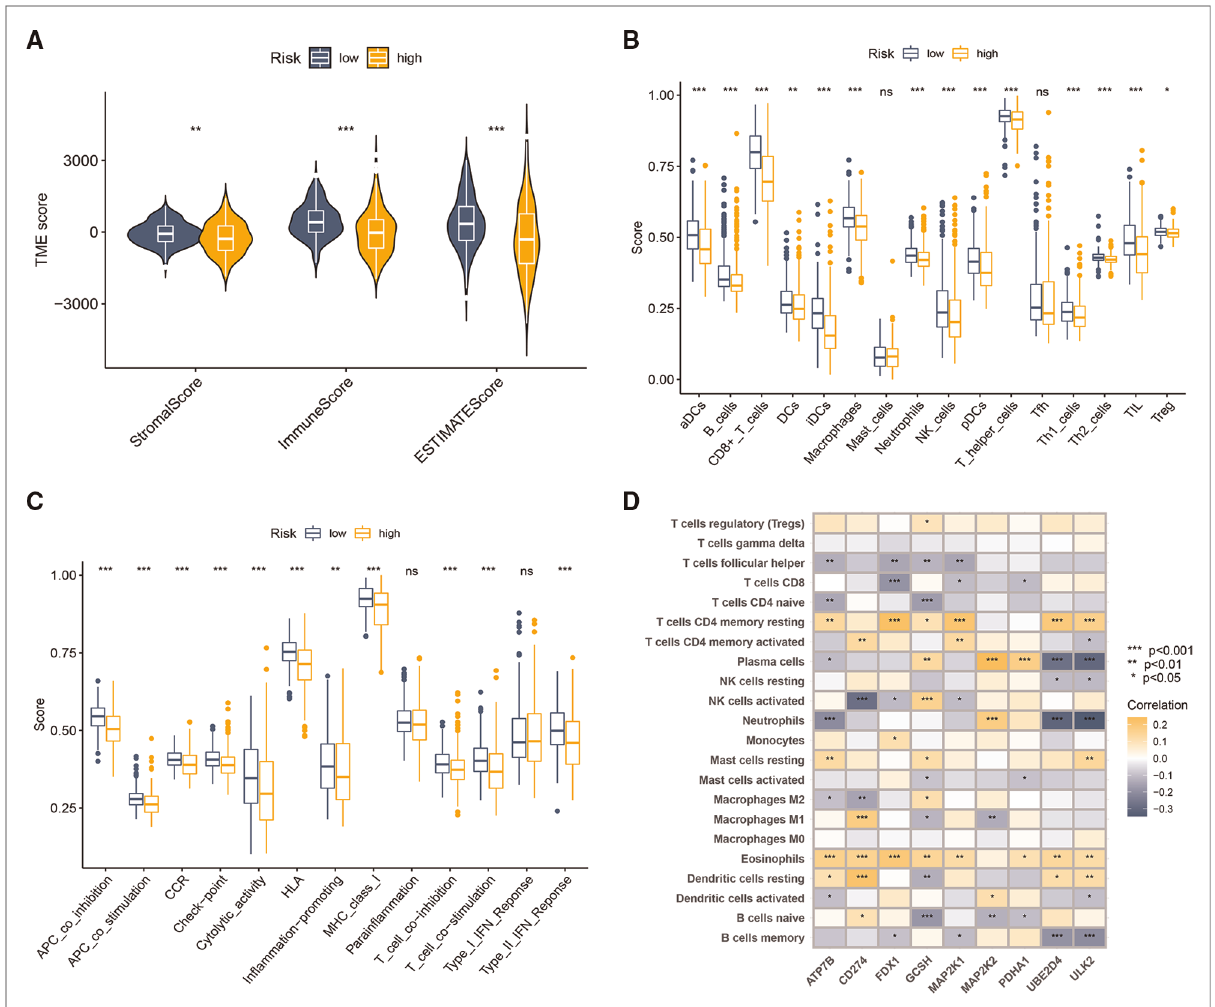
FIGURE 4 Immune-related analysis between high-risk and low-risk groups. ( A ) The variance analysis of the ESTIMATE score, stromal score, and immune score in the different CRG-score groups. ( B ) The immune in fi ltration of immune cell types in high and low CRG-score patients. ( C ) Analysis of immune functions in high and low CRG-score patients. ( D ) Correlation analysis of 9 model CRGs and 22 types of immune cells. * p <0.05, ** p <0.01, *** p